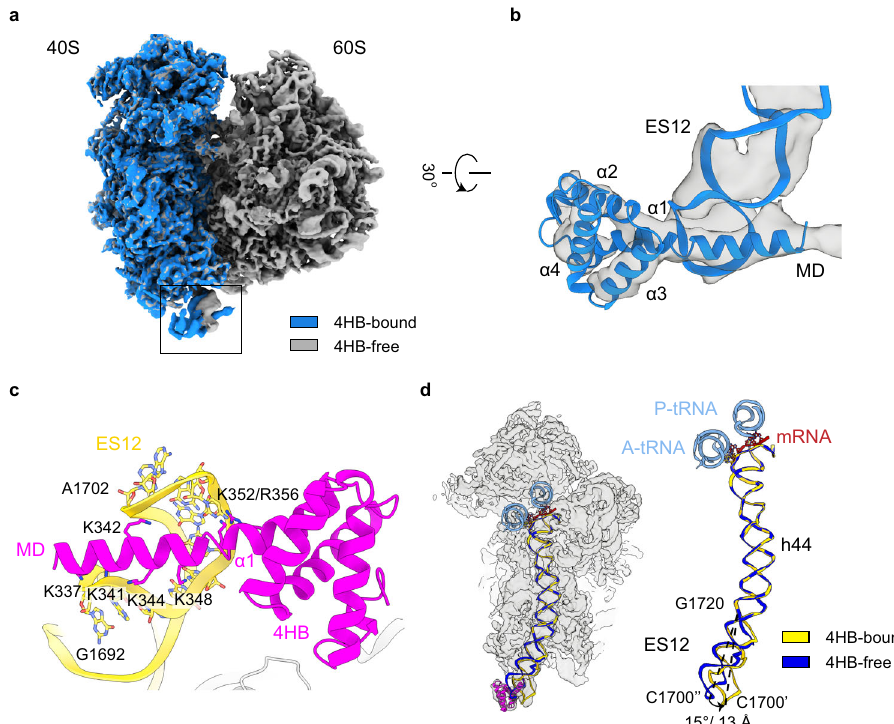
Fig. 3 Conformational modulation of h44 by RAC 4HB. a Cryo-EM maps of 4HB-bound (blue) and 4HB-free (gray) RNCs. The density maps of the two RNCs are from Map 2.5 and Map 2.7 in Supplementary Fig. 6. The alignment was done with the 60S subunit as reference. b Magni fi ed view of the boxed region in a , highlighting the fi tting of Zuo1 4HB into the cryo-EM density (Map 2.6). c Molecular model of interactions between basic residues of MD-4HB and ES12. MD-4HB and ES12 are colored magenta and gold, respectively. d Structural modulation of h44 by RAC-ES12 interaction. Cryo-EM map of the 40S subunit in 4HB-bound state (Map 2.5), superimposed with the atomic model of the MD-4HB and the models of h44 in the two states. The models of h44 from 4HB-bound and 4HB-free RNC are colored gold and blue, respectively. The mRNA and tRNAs are shown in red and light blue,